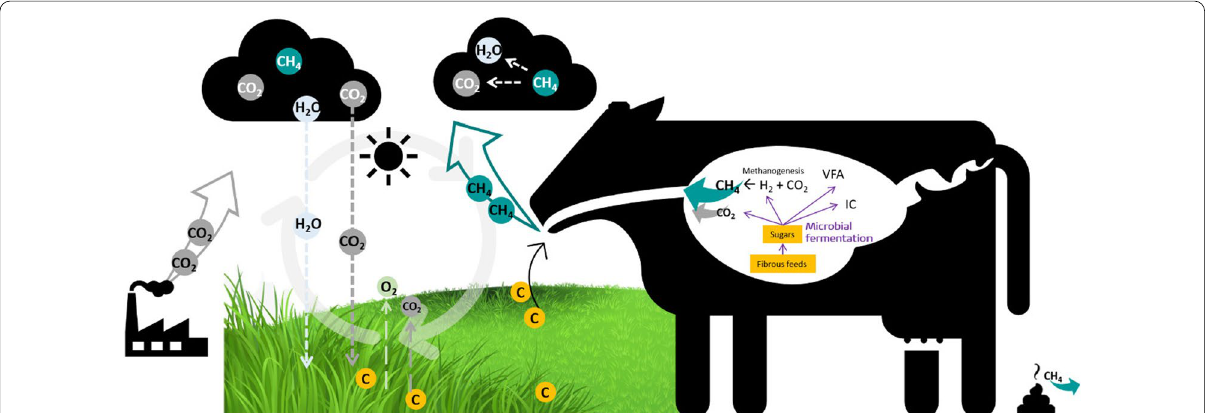
Fig. 1 Simplified scheme of rumen methane production and emission and the biogenic carbon cycle. C designates carbon, fixated in plants from CO 2 through photosynthesis, which is then consumed by animals as carbohydrates. VFA, volatile fatty acids; IC, intermediary compounds and/or other